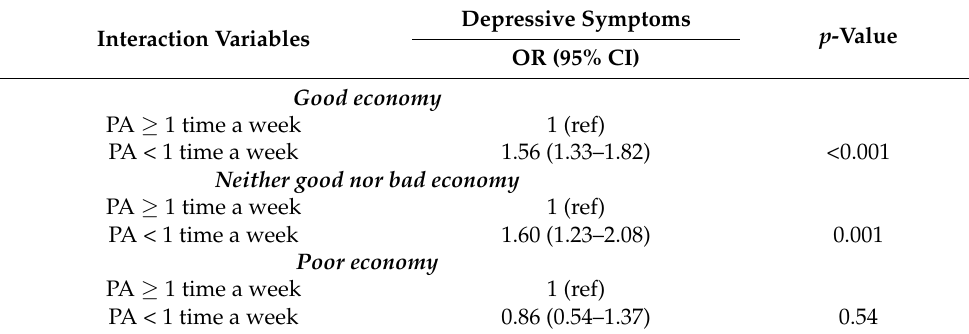
Table 5. Adjusted analysis of the moderation of family economy and physical activity in a sports club on the odds of depressive